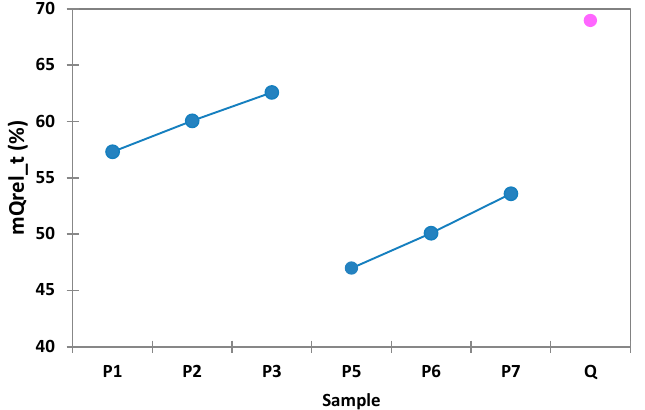
Figure 10. Interval plots of the percentage of QUE released (mQrel (%)) from the microspheres for the Sample factor levels, the pink point corresponds to the Q molecule.